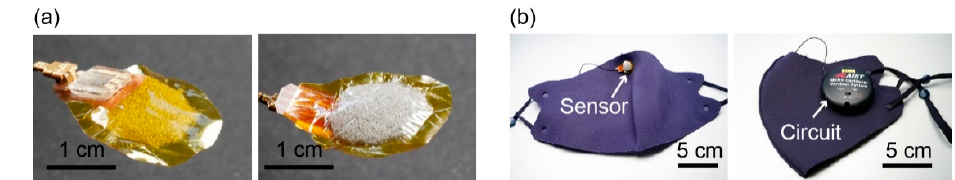
Figure 3. ( a ) Photographs of the fabricated sensor device. ( b ) Photographs showing the sensor device and the measurement circuit attached to a mask.